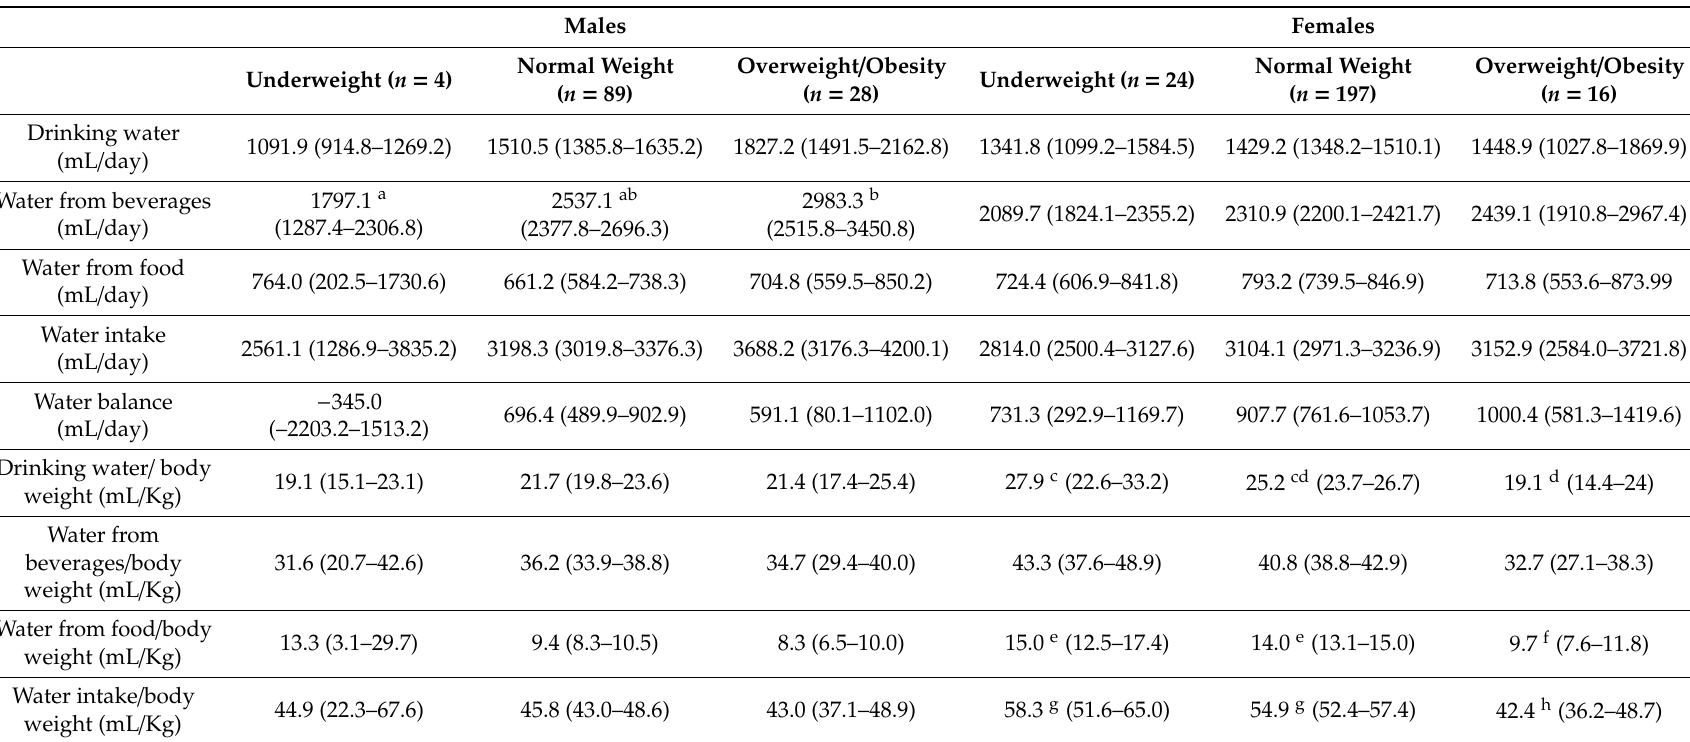
Table 5. Di ff erences in water intake variables and water balance according to body mass index and sorted by